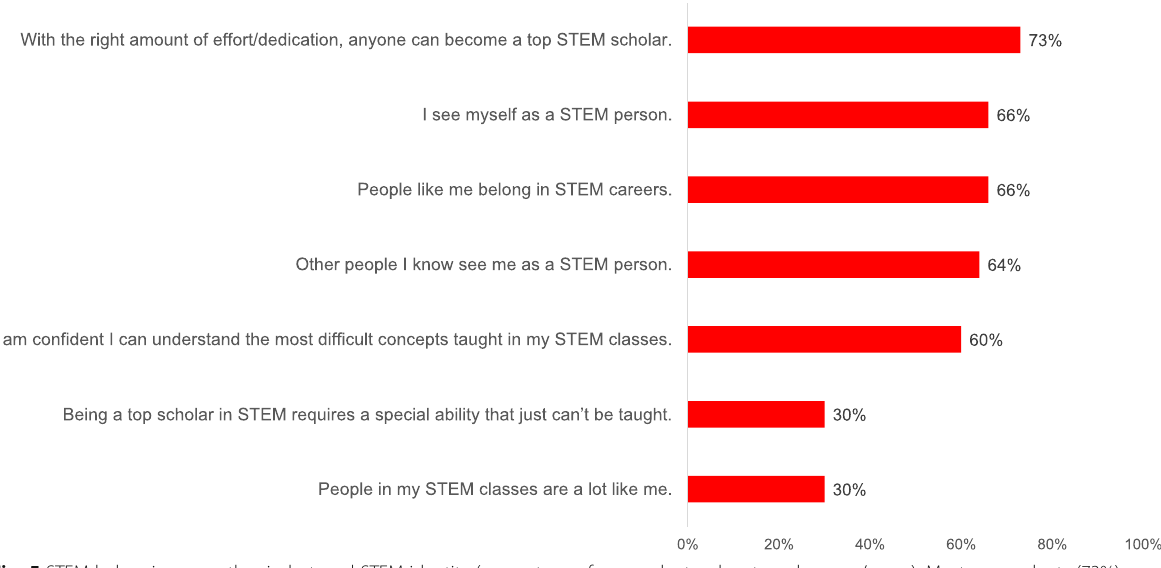
Fig. 5 STEM belonging, growth mindset, and STEM identity (percentage of respondents who strongly agree/agree). Most respondents (73%) demonstrated a growth mindset, believing that with the right amount of effort and dedication, anyone can become a top scholar in STEM. However, even though they were pursing STEM, not all felt like they belonged in STEM careers (66%), saw themselves as a STEM person (66%), or felt that people in their STEM classes were a lot like them